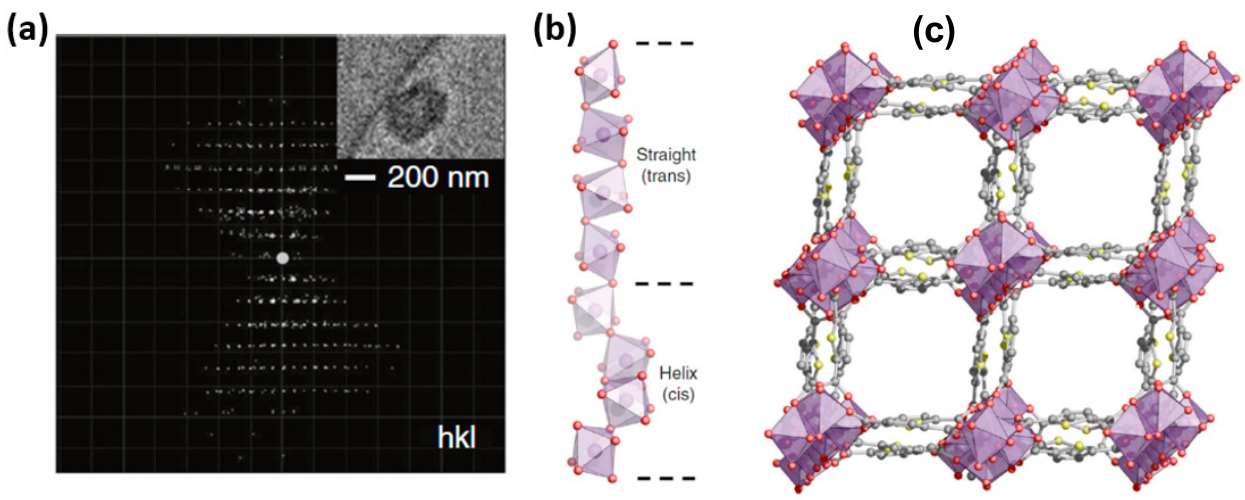
Figure 3. ( a ) Reconstructed 3D reciprocal lattice from cRED data of a nano-sized single-crystal (inset) of CAU-23. ( b ) The repetition of cis and trans corner-sharing AlO 6 polyhedra forming the inorganic building unit of CAU-23. ( c ) The 3D structure of CAU-23 projected along [010]; water molecules are omitted for clarity [87]. Reproduced from ref. [87] with permission from the Springer Nature, copyright 2019.